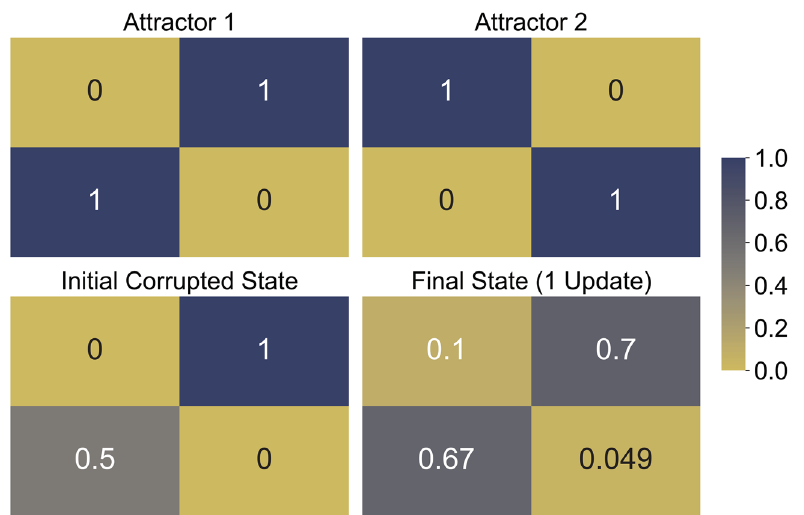
4 , single update system = x 3 corrupted to | �